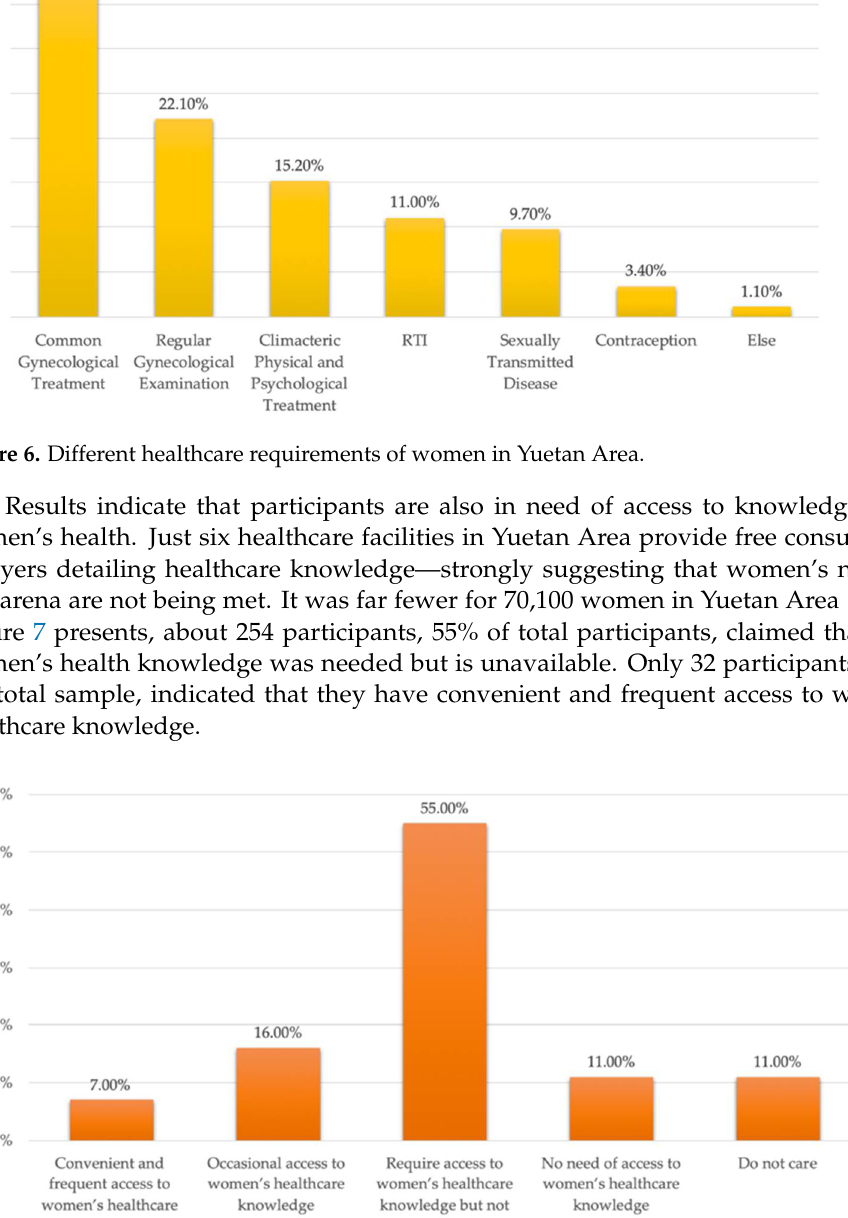
8 of 14 Table 1. Areas of health centers and service targets of Yuetan Area. No.